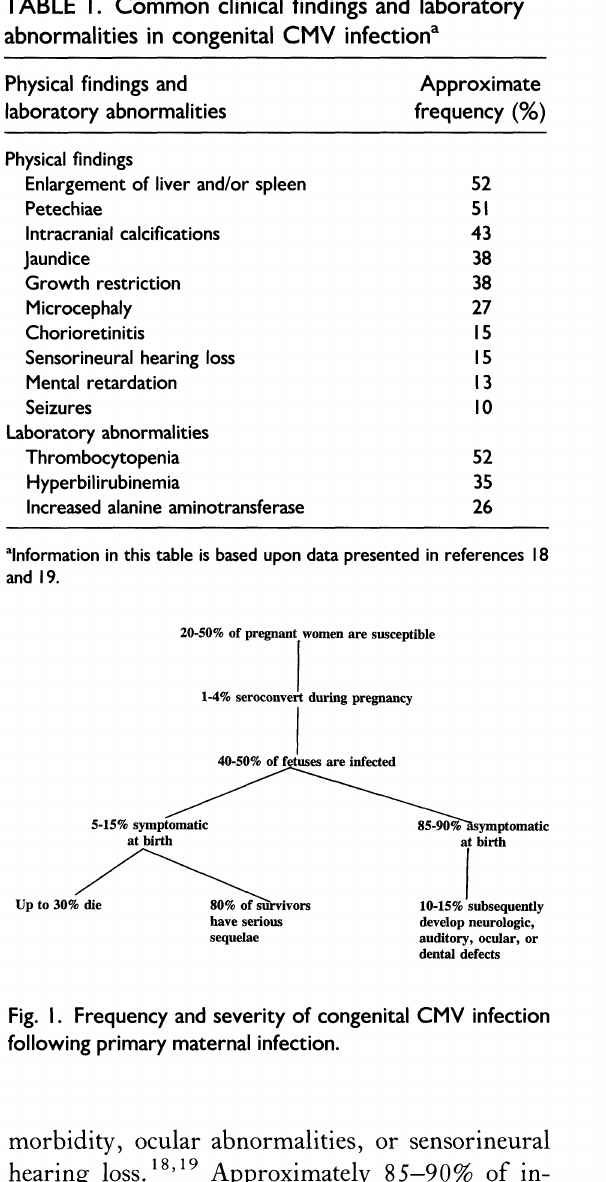
TABLE I. Common clinical findings and laboratory